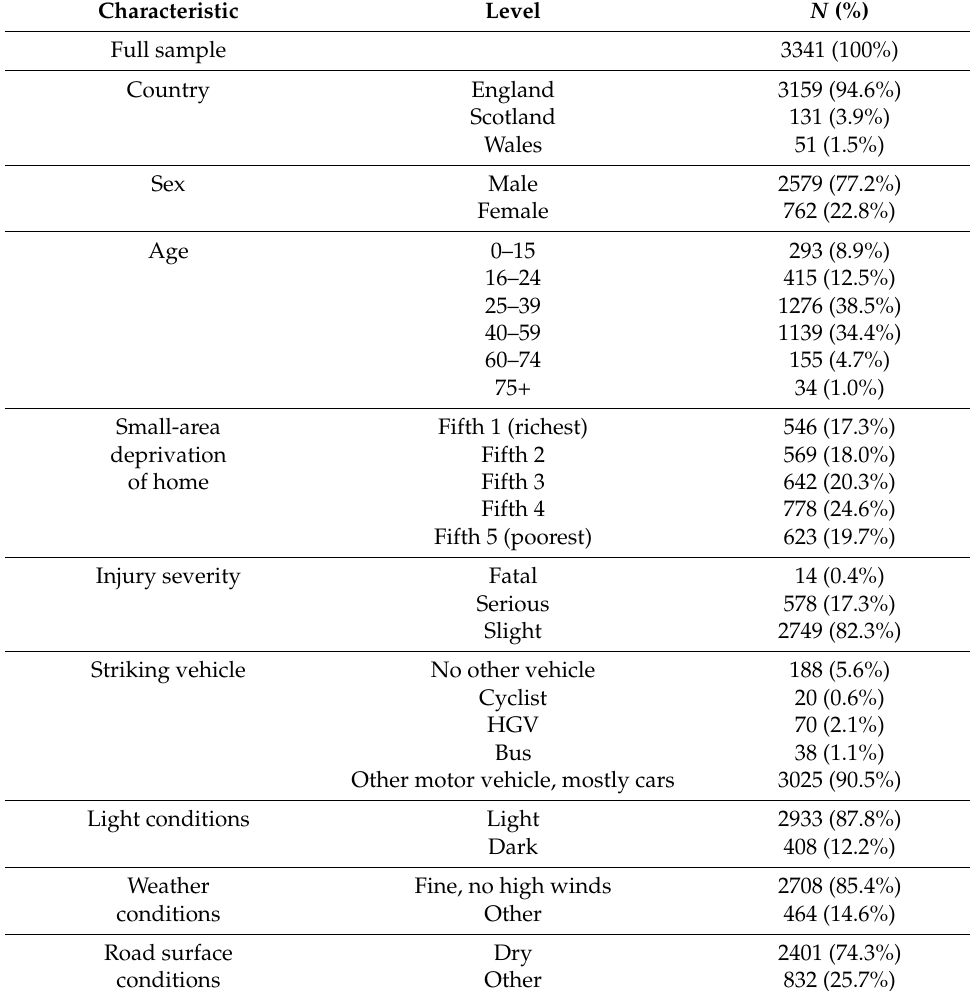
Table 1. Characteristics of individuals and of their